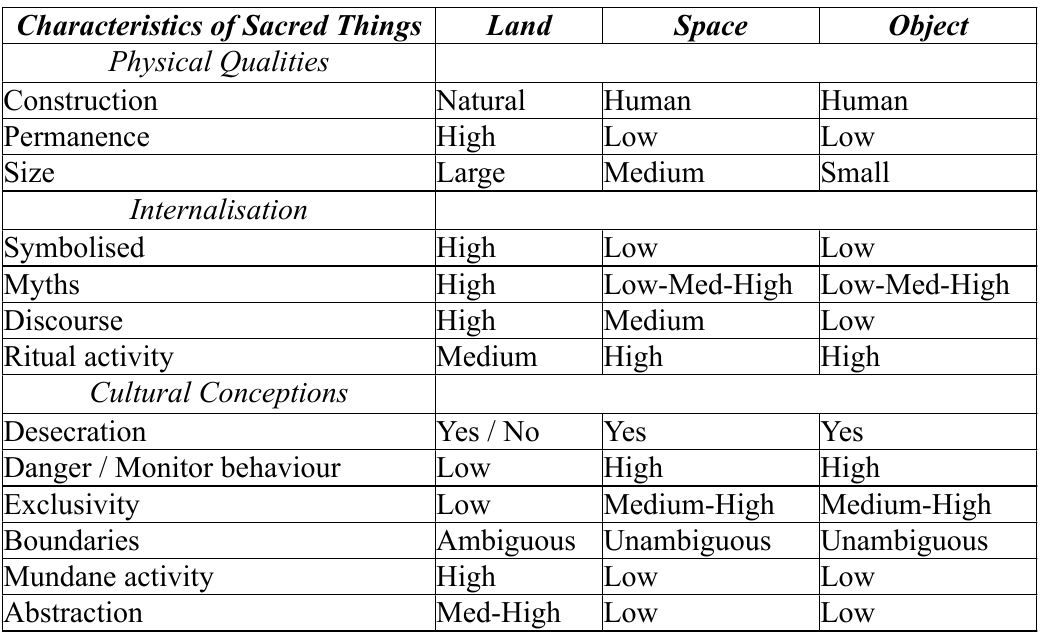
Table 1: Summary of comparison between sacred land, space, and